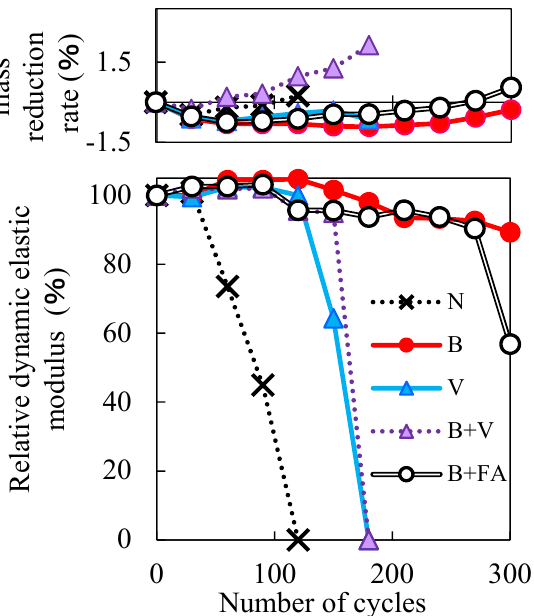
Figure 7. Variation curves of mass reduction rate and relative dynamic elastic modulus measured dur- ing freeze/thaw test in spray